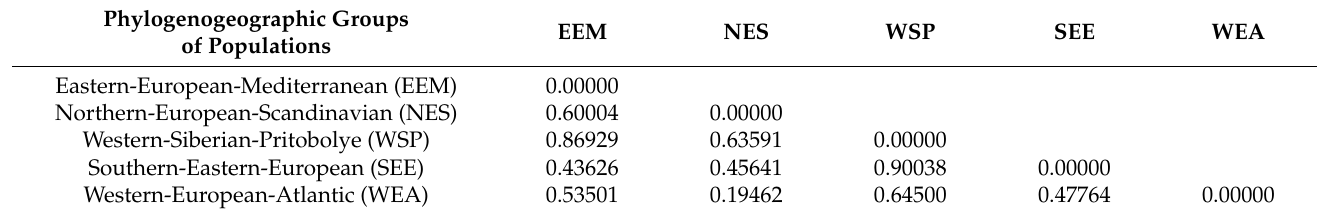
Table 1. Genetic distances (F ST ) between groups of C. vulgaris